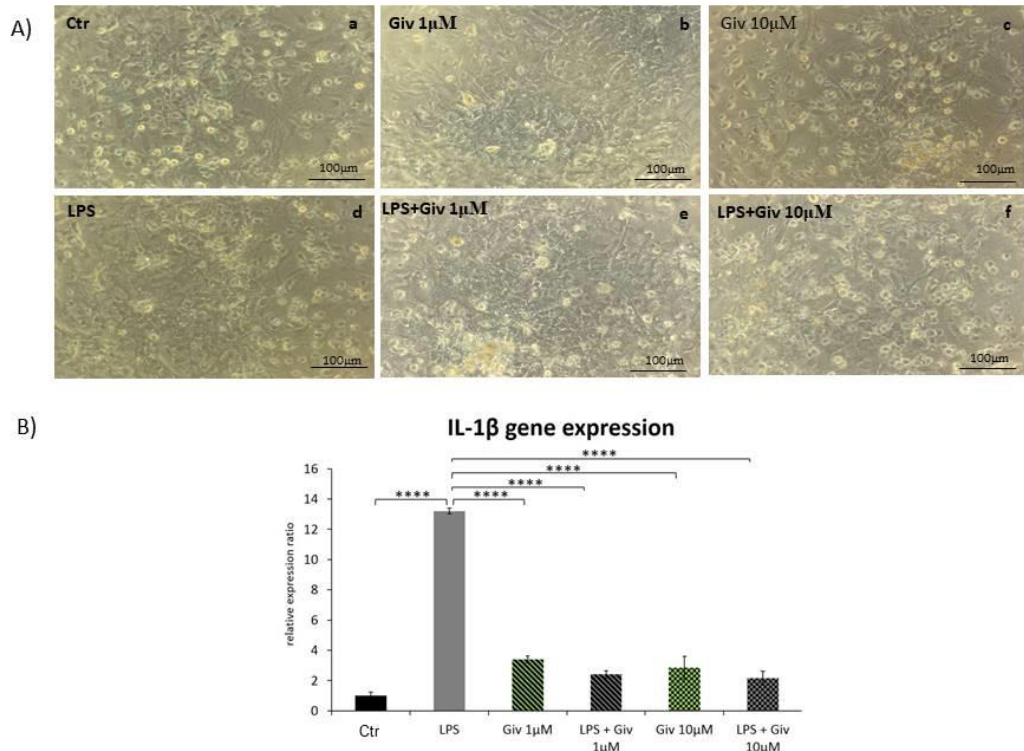
Figure 1. The effect of Givinostat on primary glial cells exposed to LPS. ( A ) Supravital photomicro- graphs of primary glial cell cultures: untreated ( a ), treated with 1 µ M Givinostat ( b ), 10 µ M Givinostat ( c ), LPS (0,3 µ g/mL) ( d ) and exposed simultaneously to LPS and 1 µ M ( e ) or 10 µ M Givinostat ( f ). ( B ) IL-1 β gene expression level in primary glial cell culture exposed to LPS (0.3 µ g/mL) and Givino- stat (1 µ M or 10 µ M). After 6 h of simultaneous incubation with the LPS and HDAC inhibitor, the cells were harvested, and IL-1 β gene expression was estimated by qPCR. Note that LPS increased the level of IL-1 β -expressing glial cells, whereas the presence of Givinostat restored the expression of this proinflammatory cytokine to the control level. One-way ANOVA indicated significant differences in the level of IL- 1β gene expression: **** p < 0.0001.